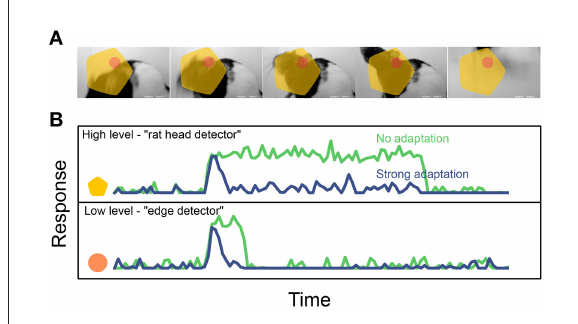
FIGURE5 Effect of short-term adaptation on the response timescale of high- vs. low- level feature detectors (cartoon). (A) Dynamical visual stimulus (movie frames). Orange dot, yellow shape: idealized receptive field of a low-level feature detector neuron (“edge detector,” orange) and a high-level feature detector (“rat head detector,” yellow). (B) Single-trial response of the two example neurons, when adaptation is absent (green trace) and when adaptation is strong (blue trace). Note how adaptation shortens the timescale of the response. Reproduced from Piasini et al. (2021). Activity traces in B are obtained by simulating a simple neural encoding model, also described in details in Piasini et al.